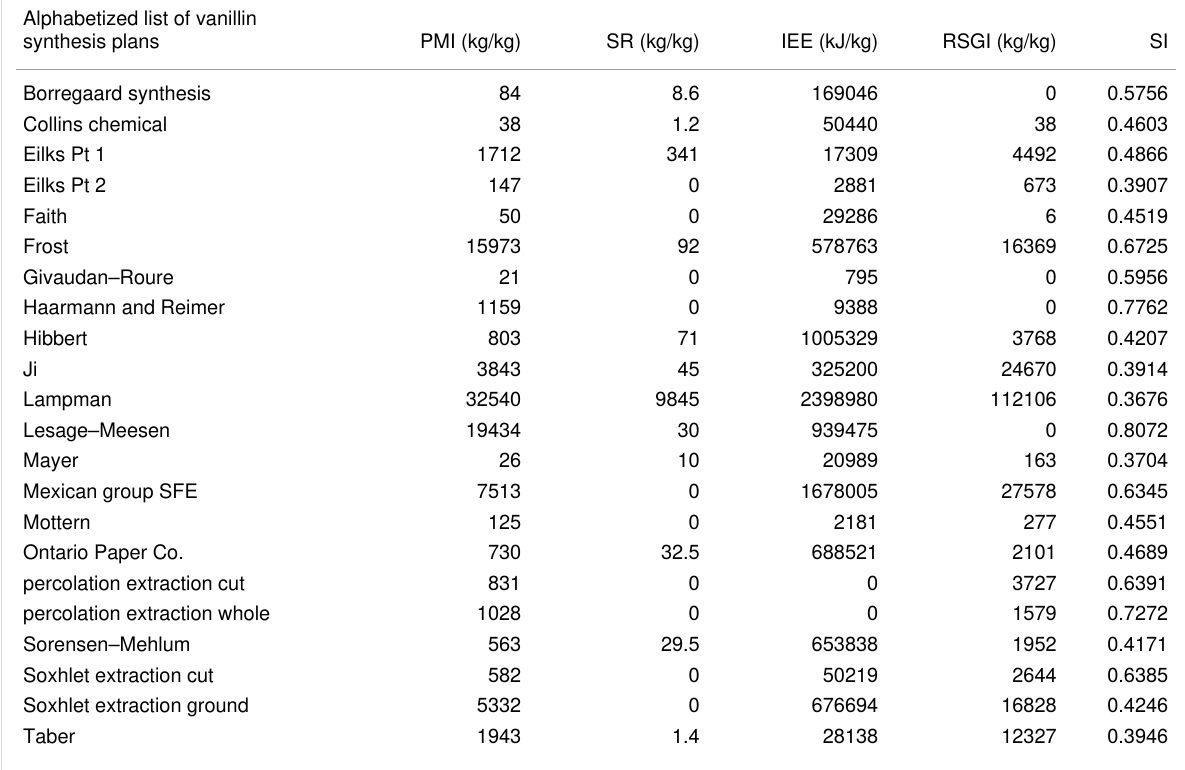
Table 3: Summary of computed values for five attributes for 22 synthesis plans of vanillin. Alphabetized list of vanillin synthesis plans